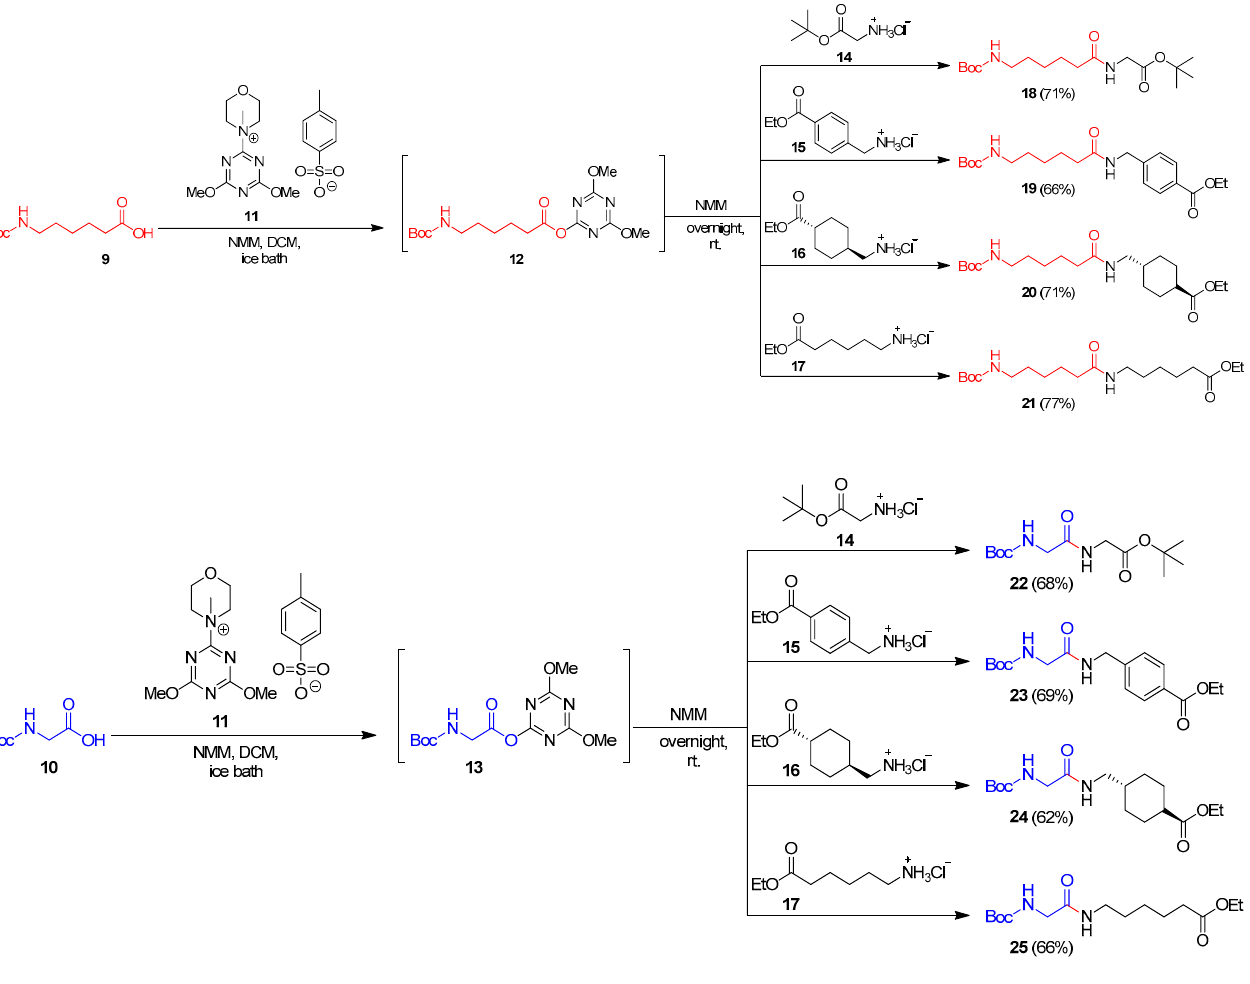
Figure 5. Synthesis of N -Boc amides 18 – 25 .